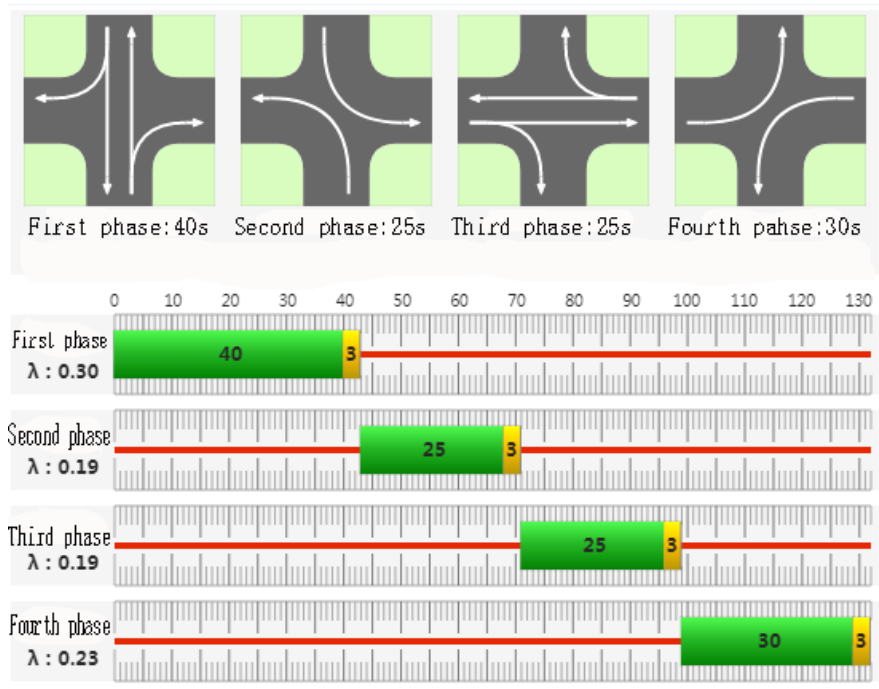
Figure 7. The actual signal timing diagram of the test intersection.